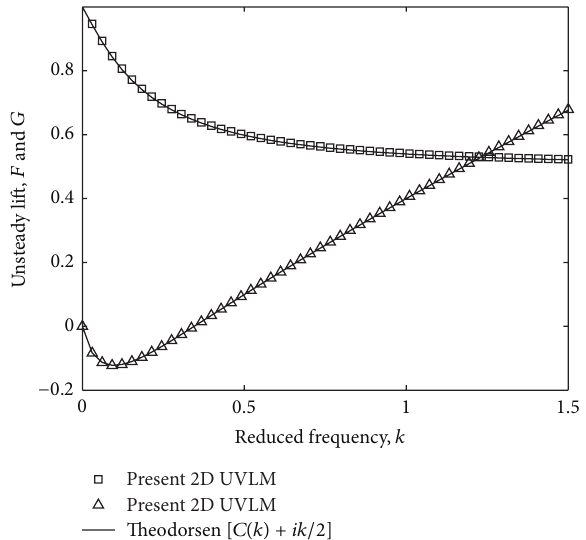
Figure 3: Eigenvalues for two-dimensional